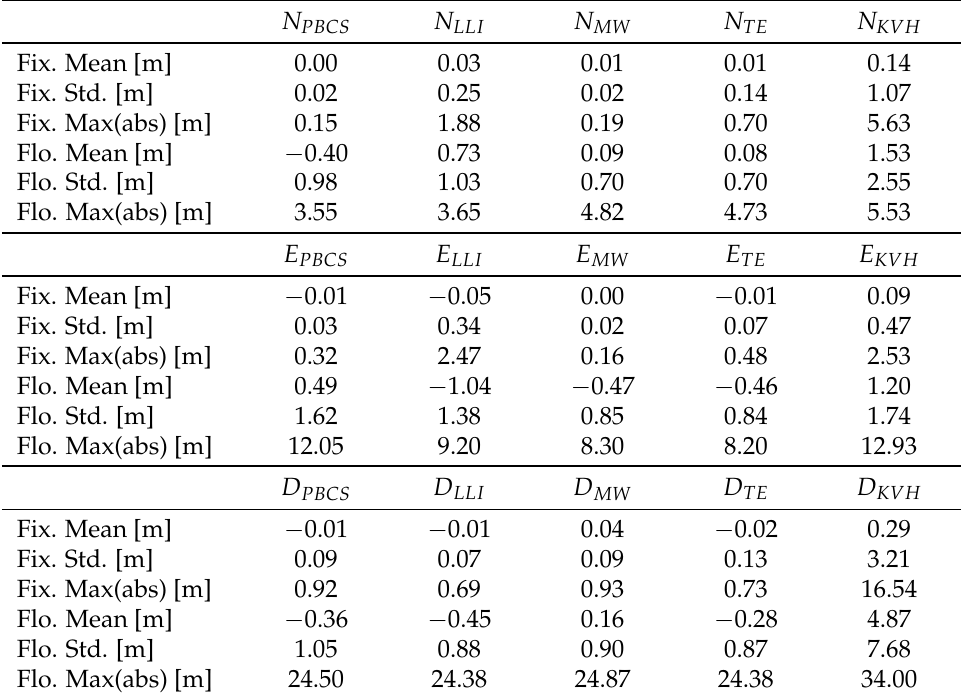
Table 11. Coordinate differences from u-blox moving base receiver—Case Study 3.